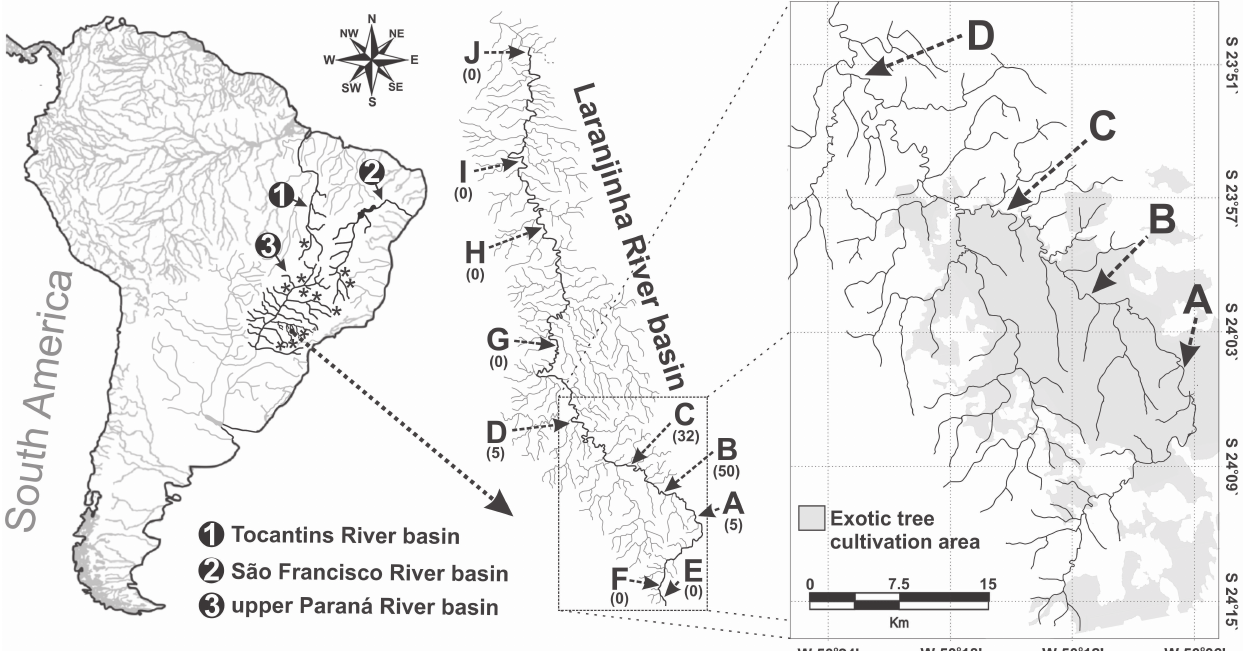
Fig. 1. Brycon nattereri sampling sites along the Laranjinha River (A, B, C and D). Also shown are the sampling sites used in a previous study (D, E, F, G, H, I and J) and the number of individuals of B. nattereri collected at each site (in parentheses). On the South America map, numbers and arrows indicate the Paraná, Tocantins, and São Francisco basins and the asterisks indicate the areas with records of Brycon nattereri (Rosa, Lima, 2008; Viana et al ., 2013; Frota et al .,